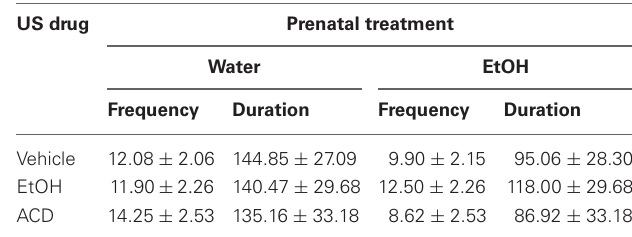
from water controls in the same experiment (p <